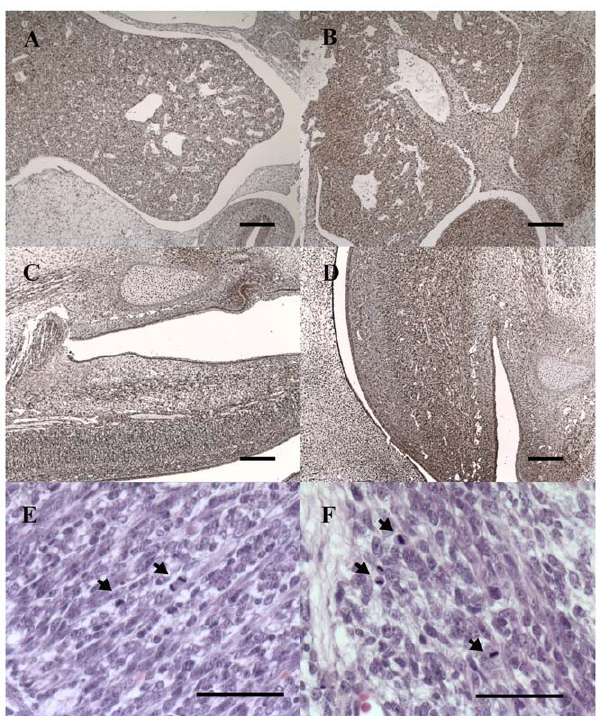
Figure 5. Immunohistochemical stain of PCNA in control and parthenogentic canine fetuses. PCNA staining for proliferating cells in day 30 control (A, C) and parthenogenetic (B, D) canine fetuses, demonstrating similar distribution patterns of dark brown PCNA- positive cells in regions of fetal liver (A, B) and brain (C, D). Day 30 parthenote (F) showed a similar level of mitotic figures (arrows) to those of control (E). Scale bars in A–D, 200 m m. Scale bars in E–F, 50 m m.